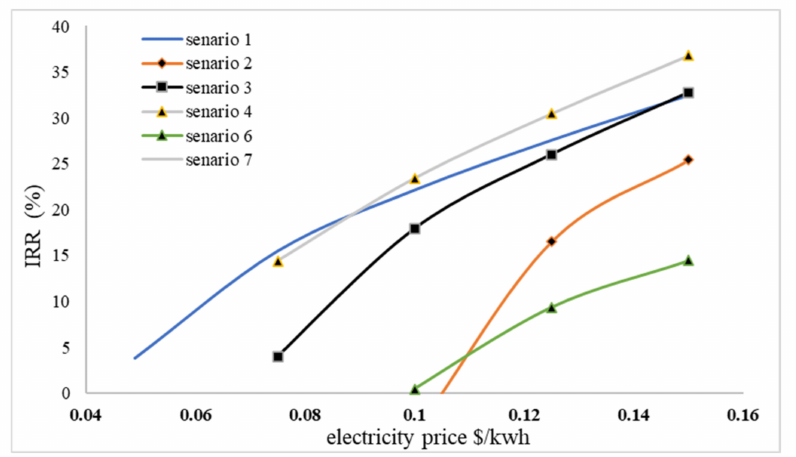
Figure 7. IRR changes based on the selling price of electricity.